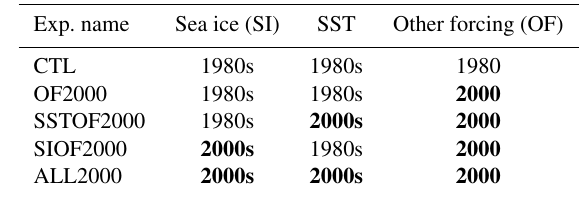
Table 1. Sea surface temperature (SST), sea ice, and other forc- ing conditions in the sensitivity experiments with MIROC5-AGCM. Other forcings include land use, greenhouse gas concentrations, aerosol emissions, and total solar irradiance. Data in the 1980s in- dicate an average over the period 1976–1985, and the data in the 2000s combine data for the 1980s and changes for the following 20 years, which were estimated using the linear trend from 1976 to 2005 in the historical simulations. Each experiment name except CTL indicates changes of the condition from CTL. The letters SI, SST, OF, and ALL before 2000 in the name indicate that, respec- tively, sea ice, SST, other (atmospheric) forcings and all the three conditions for 2000 or the 2000s were used in the experiment rather than using those for 1980 or the 1980s, as indicated by 2000 or 2000s (bold) in the